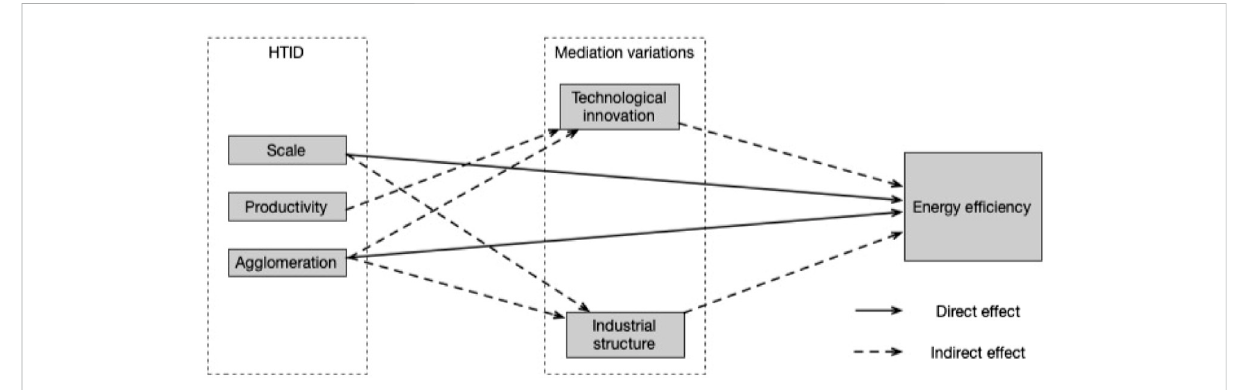
FIGURE 4 The impact of HTID on energy ef fi ciency and its underlying